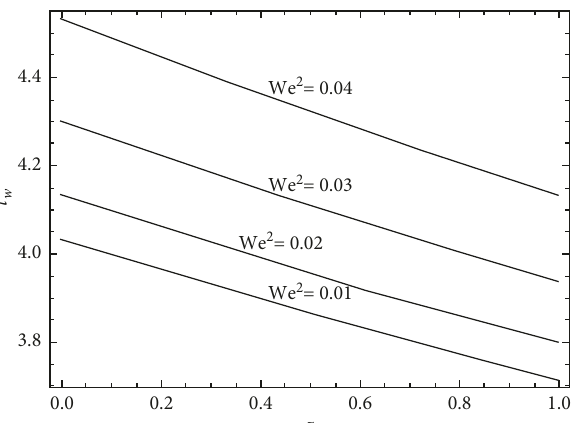
Figure 12: Variation of FR with P where K � 0.001.